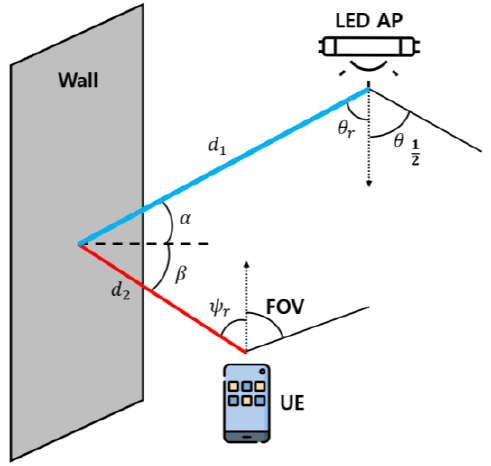
Figure 3. Non-directed path channel model between LED AP and UE.